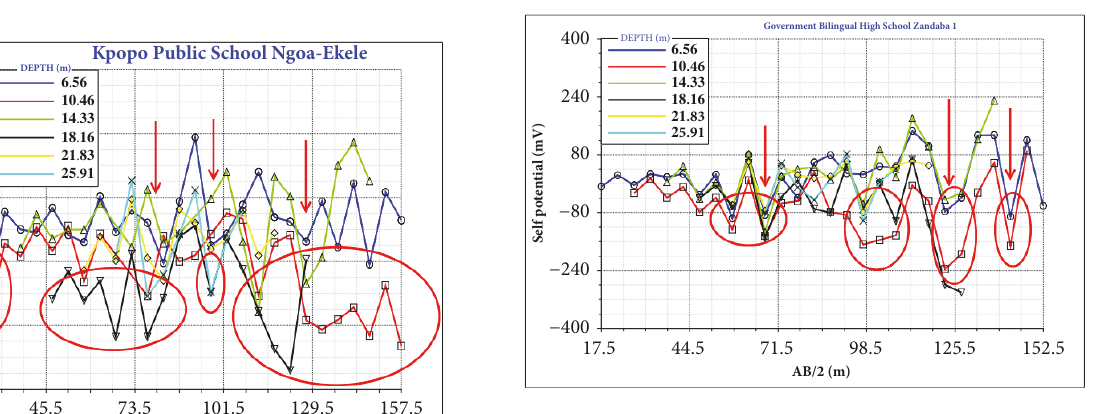
Figure18:PlotsofSPvaluesagainstHalfElectrodesSpacing(AB/2).